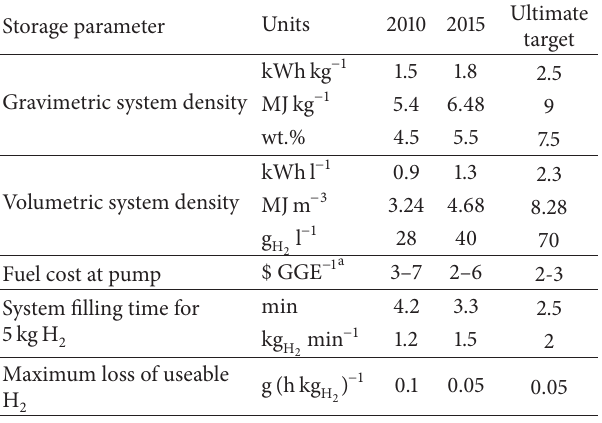
Table 3: DOE hydrogen storage targets for light-duty vehicles [41]. Storage